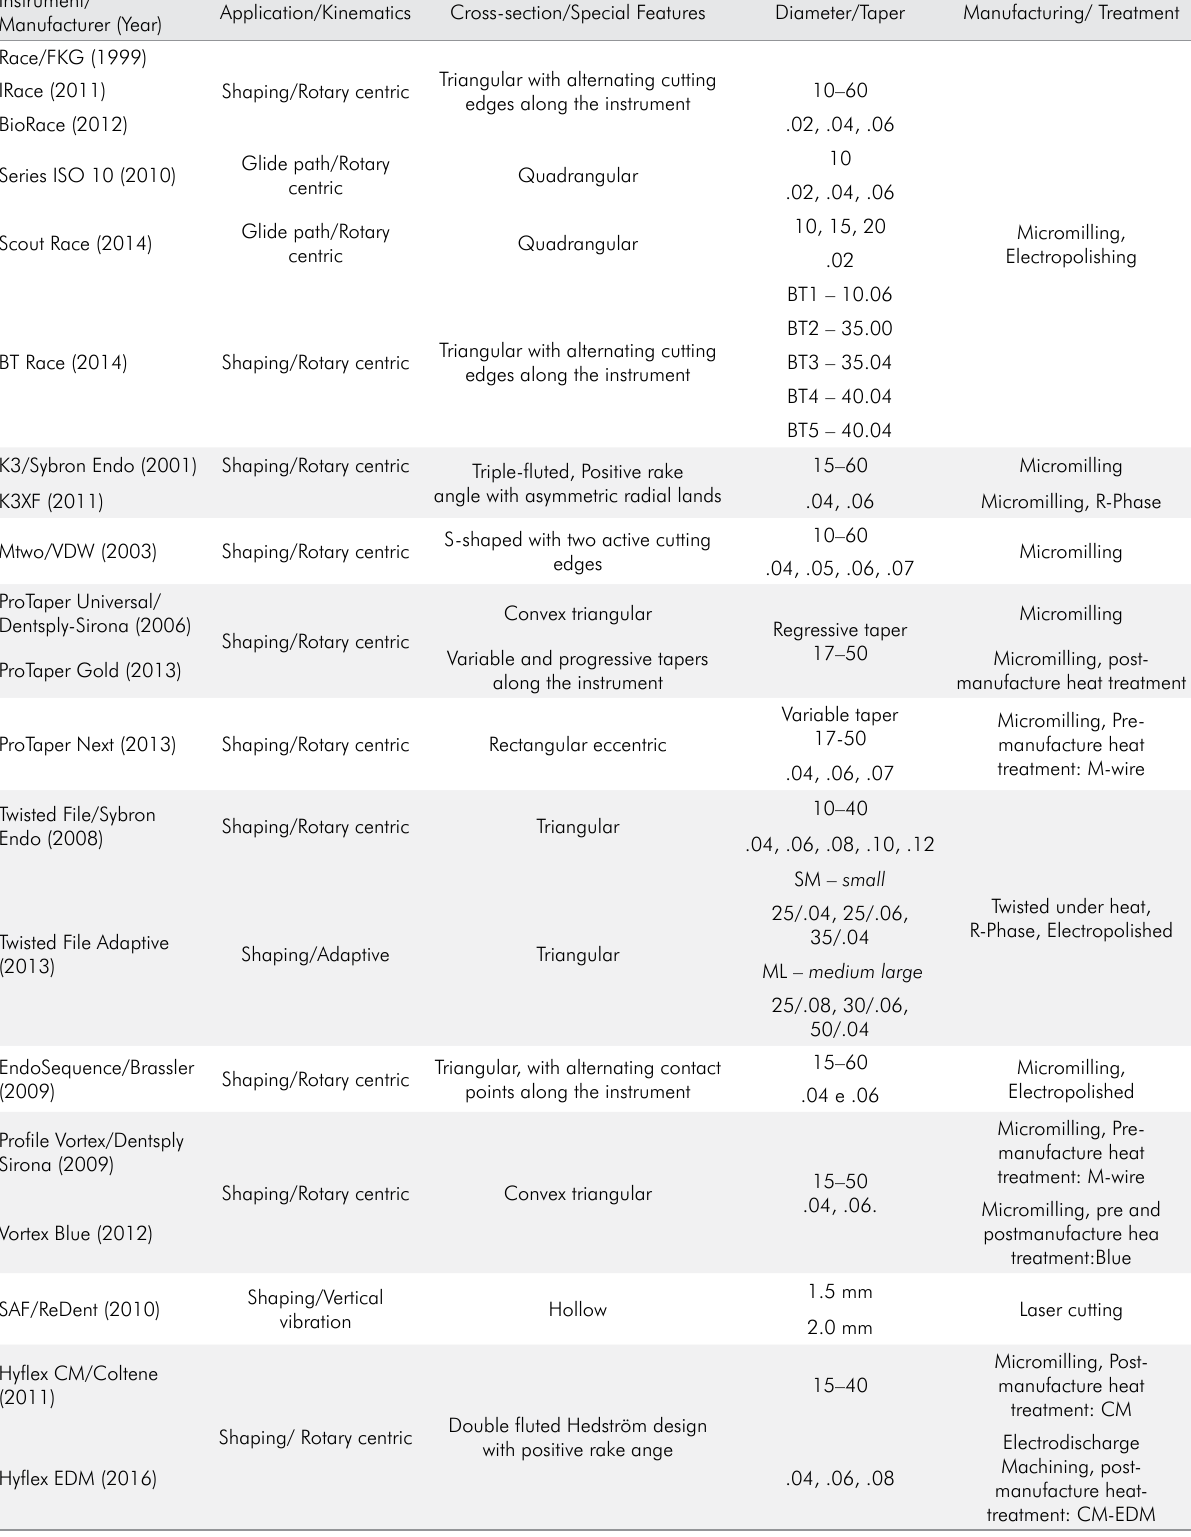
Table 1. Features of the main automated instrumentation systems in the current world